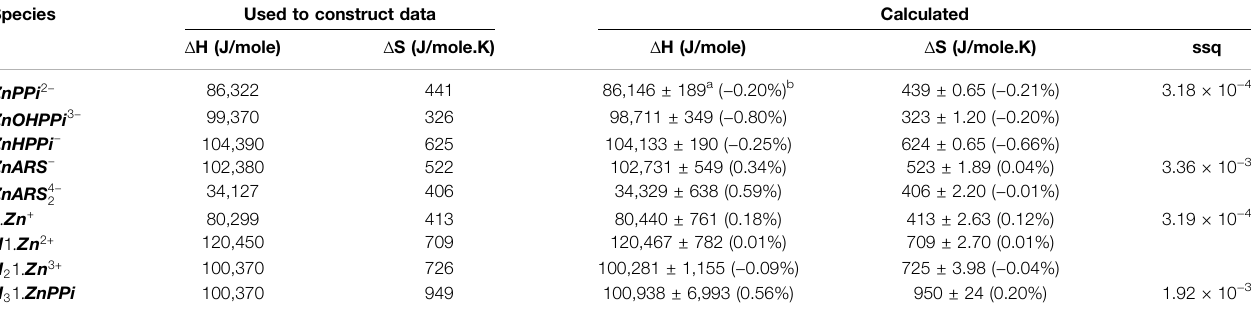
TABLE 3 | Obtained af fi nity thermodynamic constants for the simulated pH datasets corresponding to binding af fi nities of Zn 2 + to PPi, ARS and 1 . Used to construct data CalculatedSpecies Δ H